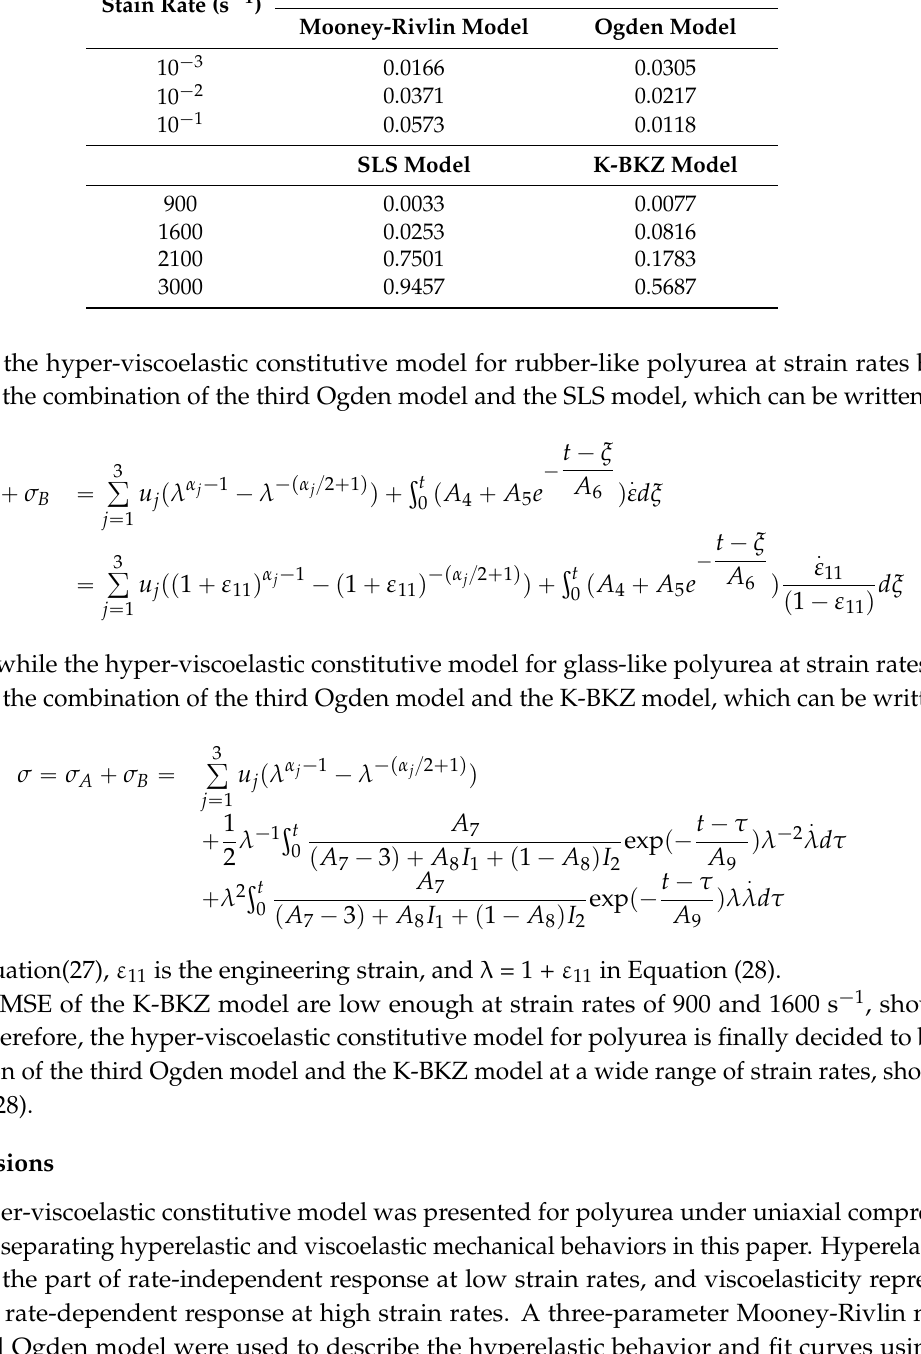
Table 2. The RMSE of different model-fitting data. Stain Rate (s ´ 1 )